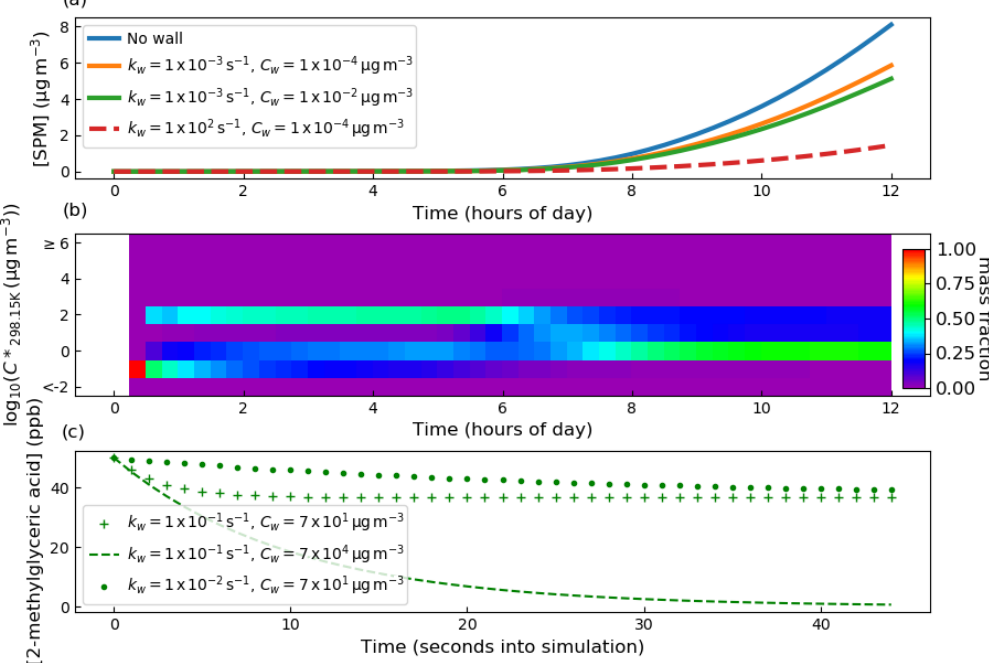
Figure 7. In (a) is the sensitivity of SPM mass concentration to the gas–wall partitioning parameters k w and C w from Eq. (7). Seed particles with a concentration of 8µgm − 3 were present at the start of the experiment. Initial concentrations of O 3 , isoprene and NO 2 were set to 21.1, 63.4 and 9.8ppb, respectively. With regards to photolysis rates, the simulation made the same considerations as in Fig. 3, where natural sunlight drove reactions after dawn at approximately 4h. Panel (b) illustrates a PyCHAM plotting tool for contributions of components in volatility bands to secondary particulate matter as a function of time. The example given is for the no-wall case in (a) . In (c) , the sensitivity of the gas-phase concentration decay of 2-methylglyceric acid is shown for a control experiment in which only a single organic component is present in the absence of particles. Wall loss parameters are given in the